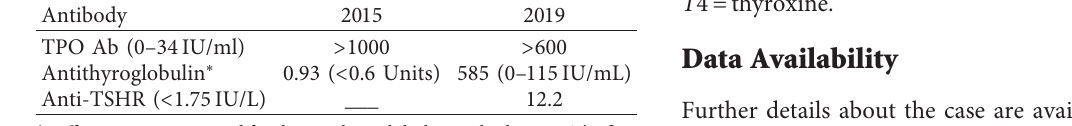
Table 2: Autoantibodies’ trend during the clinical follow-up. Antibody